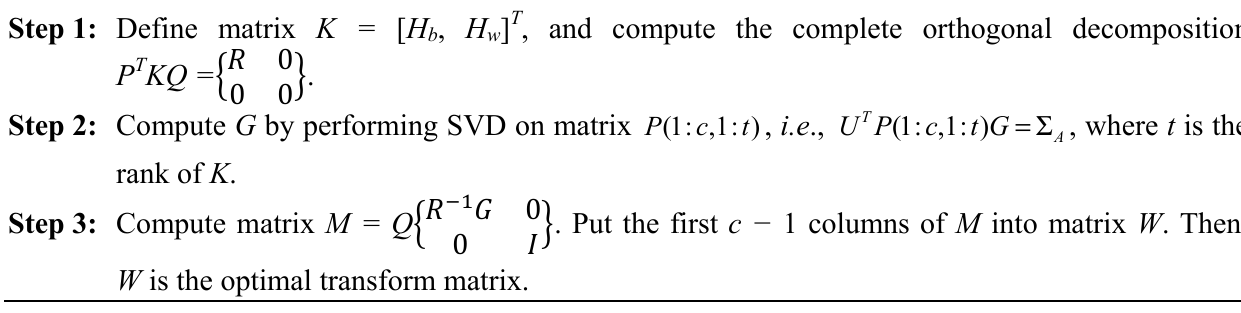
Algorithm 1. Procedures of GSVD based